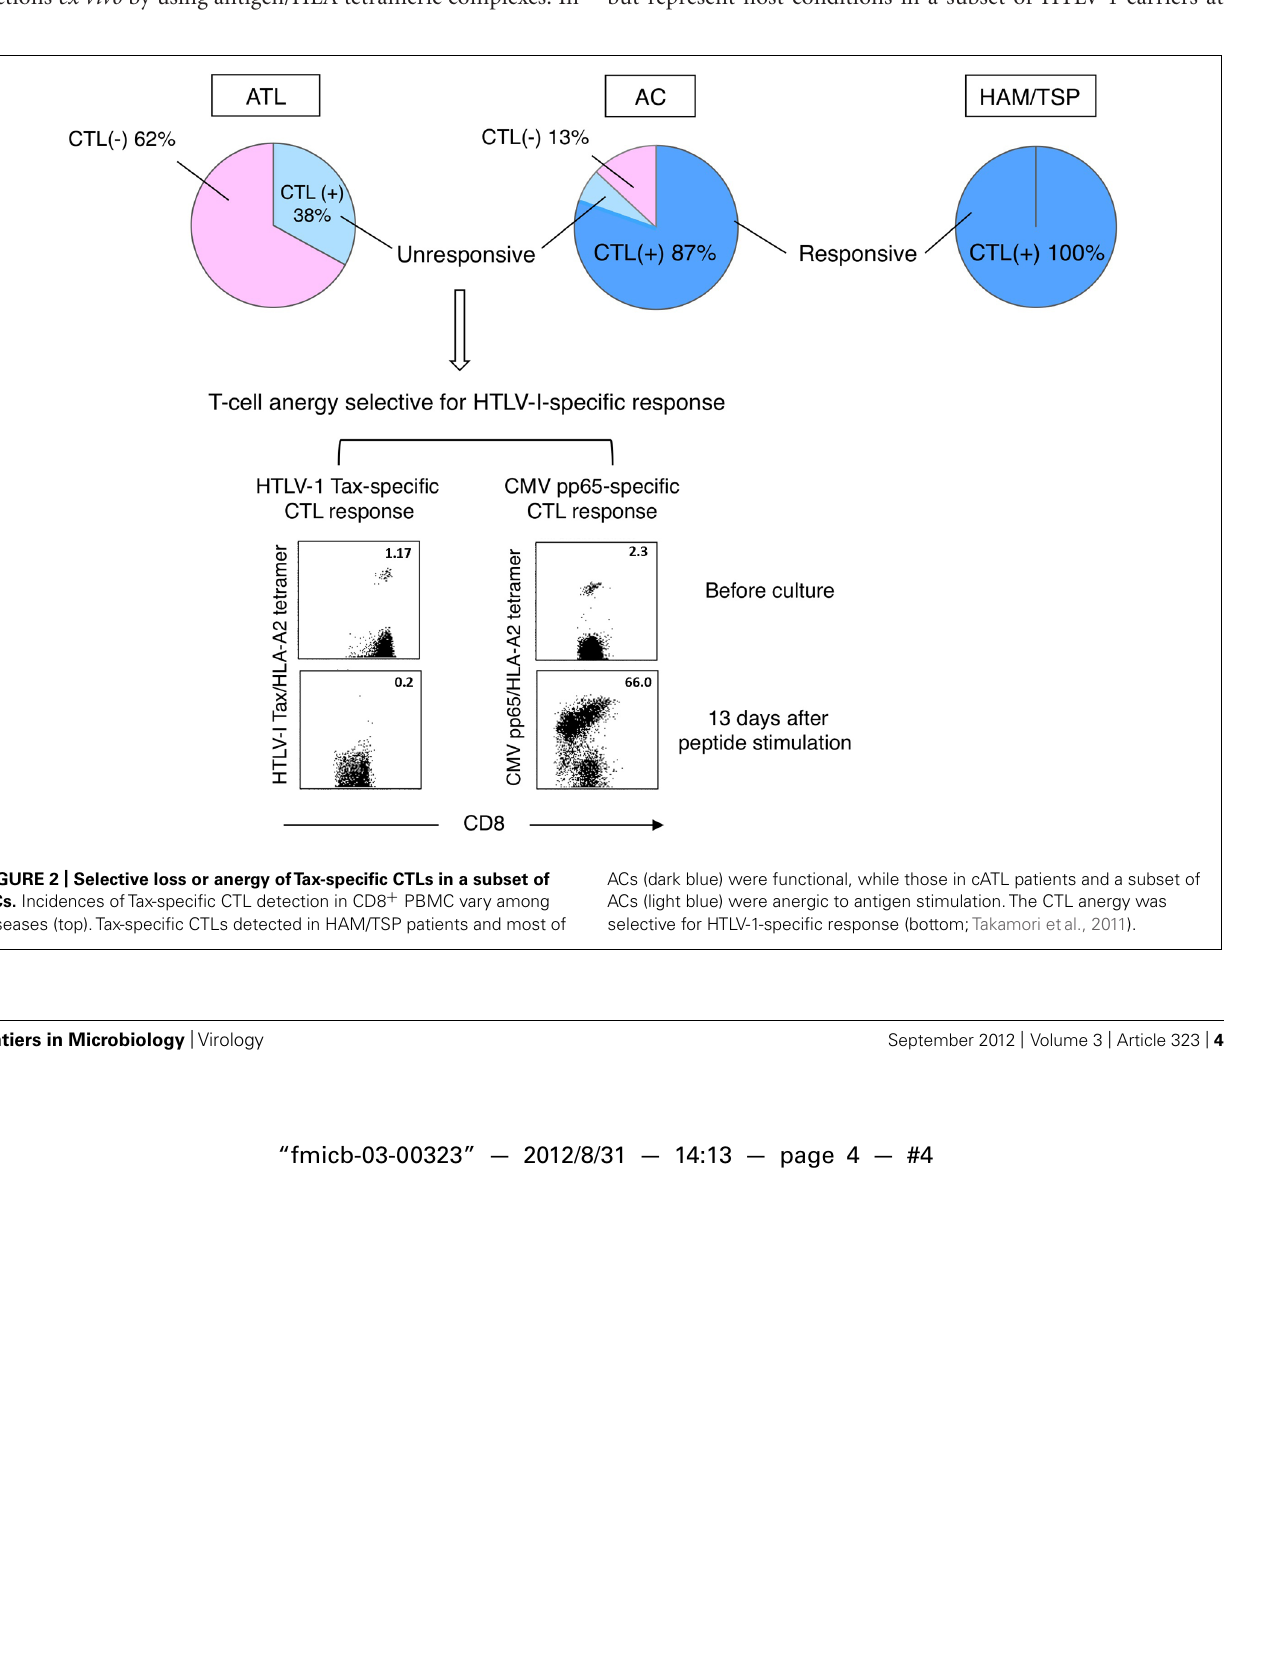
ACs (dark blue) were functional, while those in cATL patients and a subset of ACs (light blue) were anergic to antigen stimulation.The CTL anergy was selective for HTLV-1-specific response (bottom;Takamori etal.,